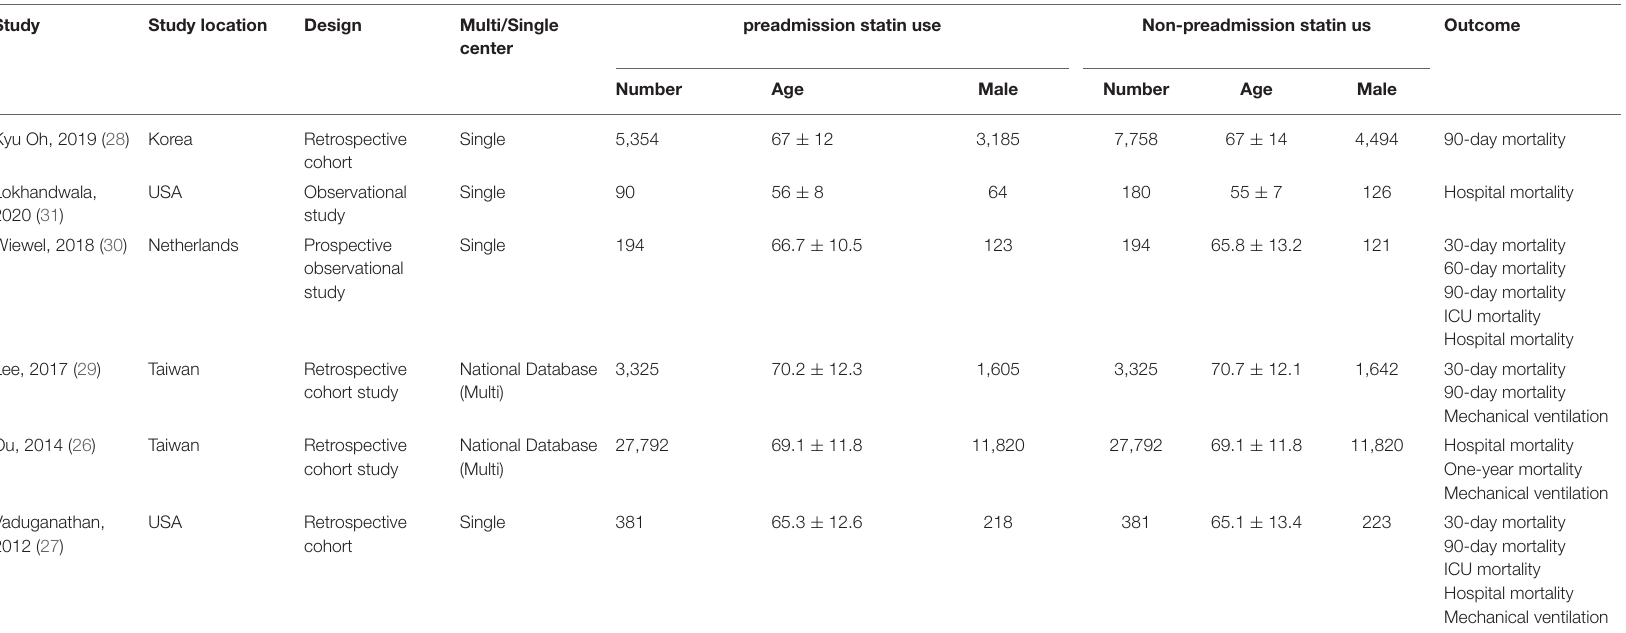
TABLE 1 | Characteristics of included